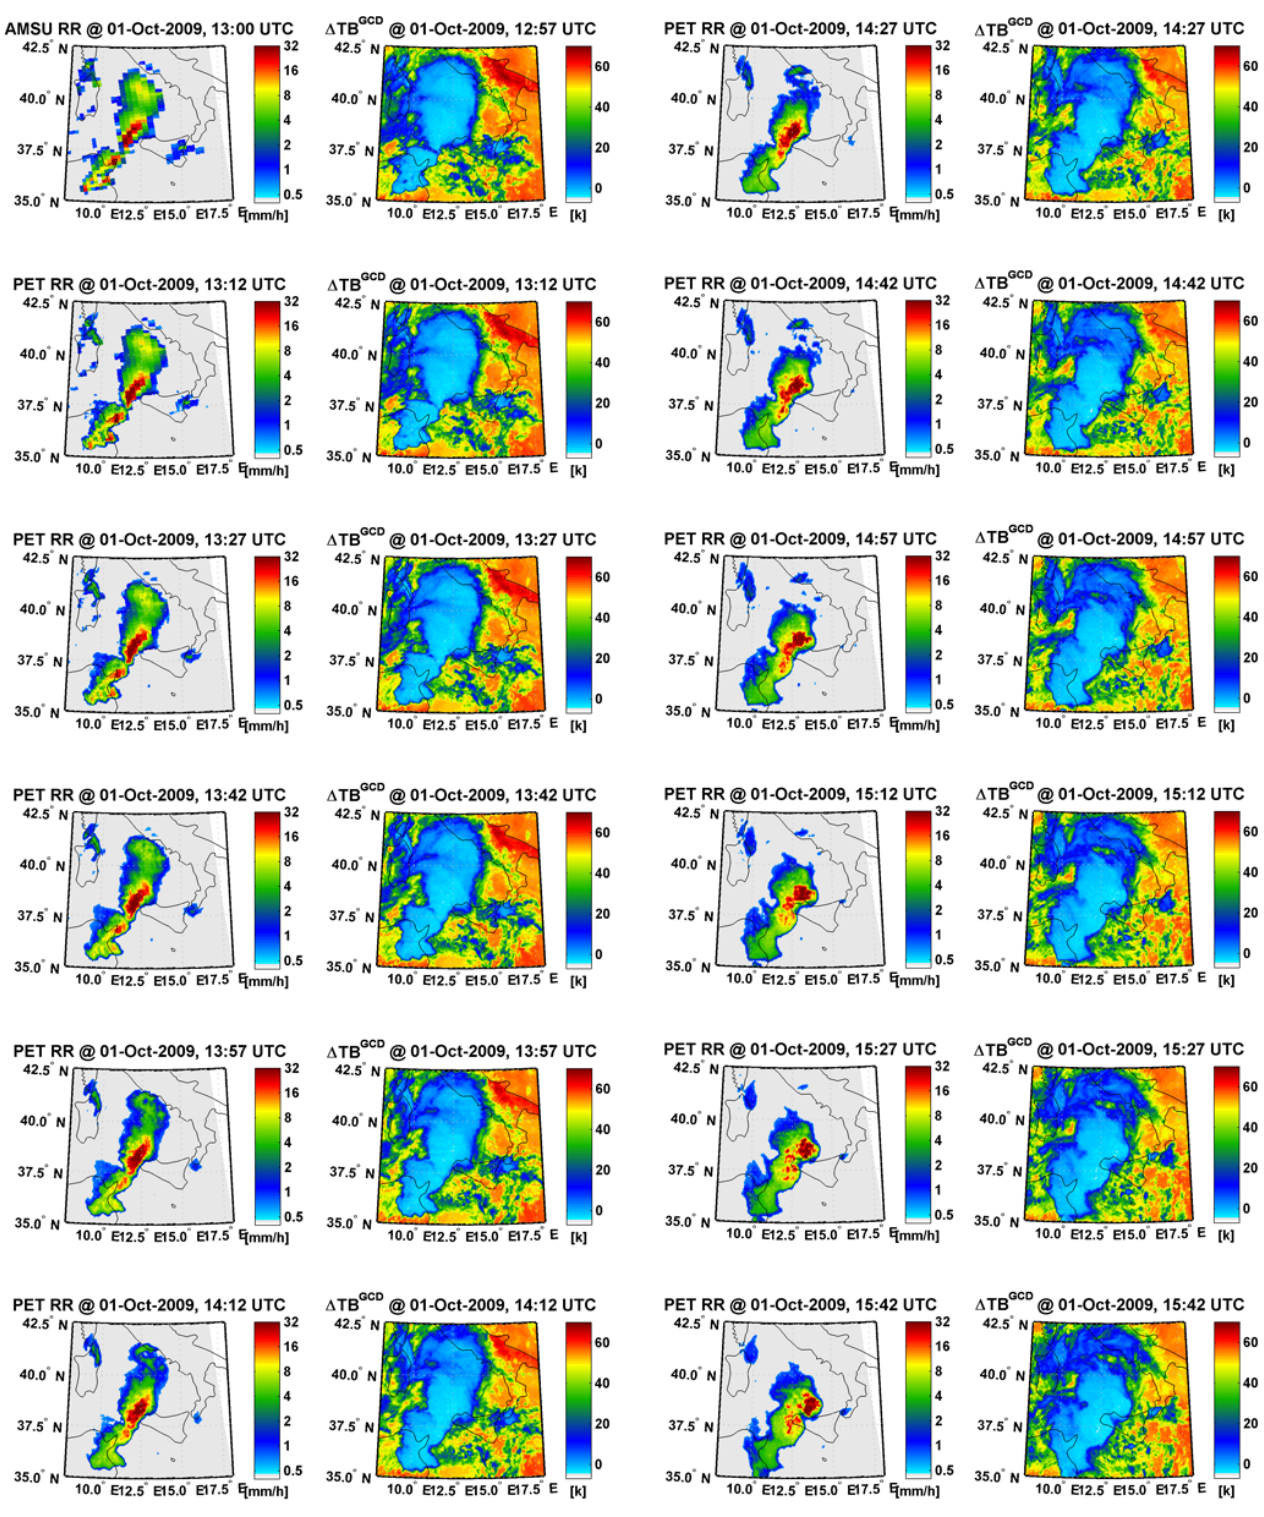
Fig. 5. Event over southern Italy, 1 October 2009. PET estimated rain-rate evolution from 13:12UTC to 15:42UTC, starting from the rain rates at 13:00UTC provided by MIT algorithm applied to TB from AMSU/MHS onboard NOAA 18 satellite, and contemporary GCD maps from SEVIRI onboard MSG, used for PET